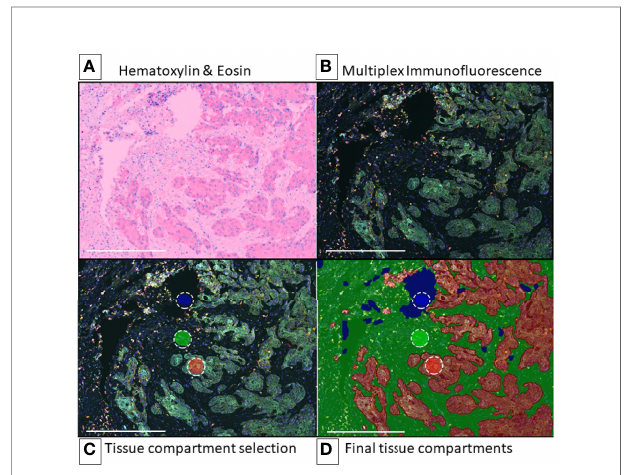
FIGURE 1 | egion of Interest and Image Preparation for Multiplex Analysis Using Tyramide Signal Ampli fi cation. Representative digital image of non-small cell lung cancer for multiplex immuno fl uorescence phenotyping analysis (10x – scale bar: 500 m m). (A) Hematoxylin & Eosin (H&E) (representative H&E image view provided by the software during analysis). (B) Multiplex immuno fl uorescence image view for ROI (composite image). (C) Multiplex immuno fl uorescence image on intratumoral region with training regions for tissue segmentation, red (tumor), green (stroma), blue (glass). (D) Region on interest (intratumoral) after training algorithm for tissue segmentation, red (tumor), green (stroma), blue (glass). Composite image from inForm ® image analysis software, Akoya bioscience. Scanner Vectra